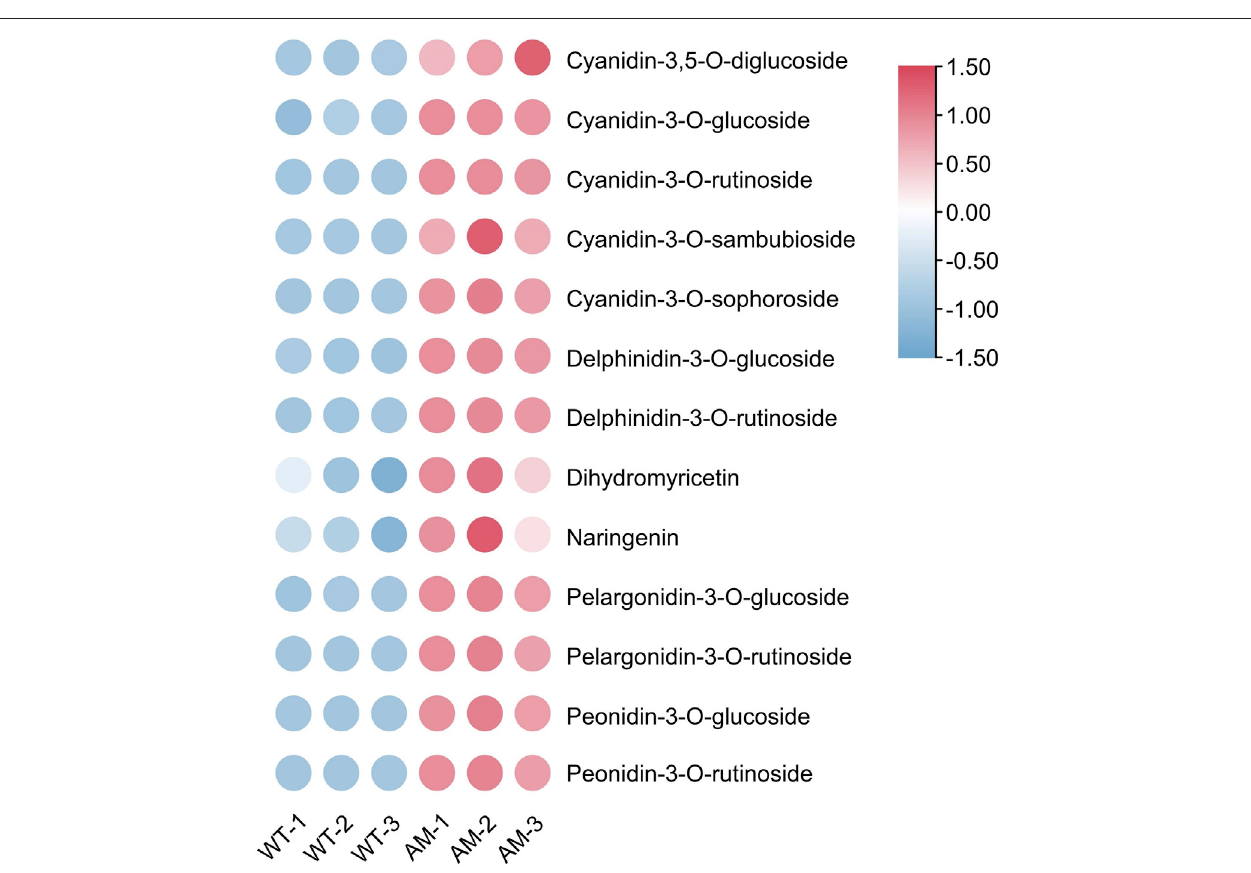
Frontiers in Bioengineering and Biotechnology |